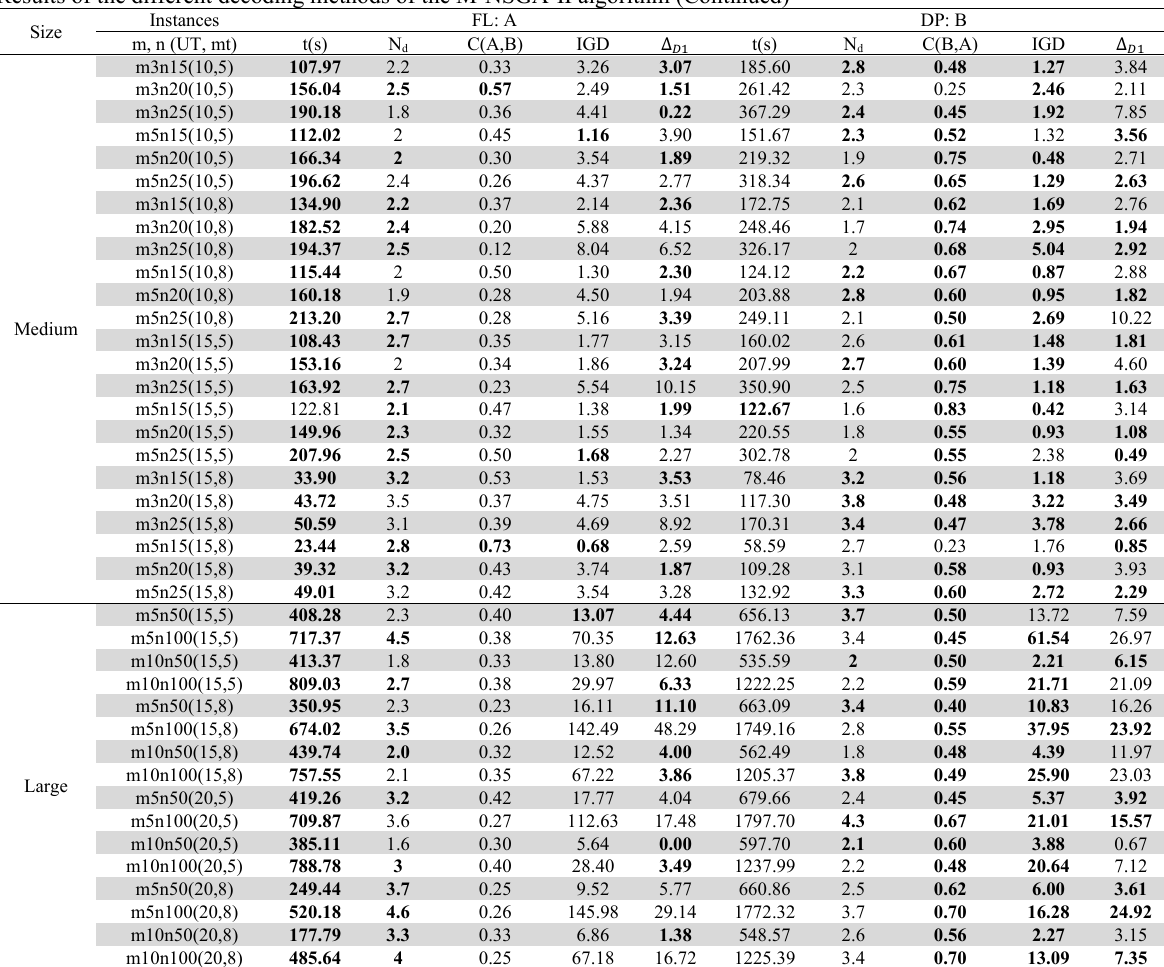
Results of the different decoding methods of the M-NSGA- Ⅱ algorithm (Continued) Instances Size